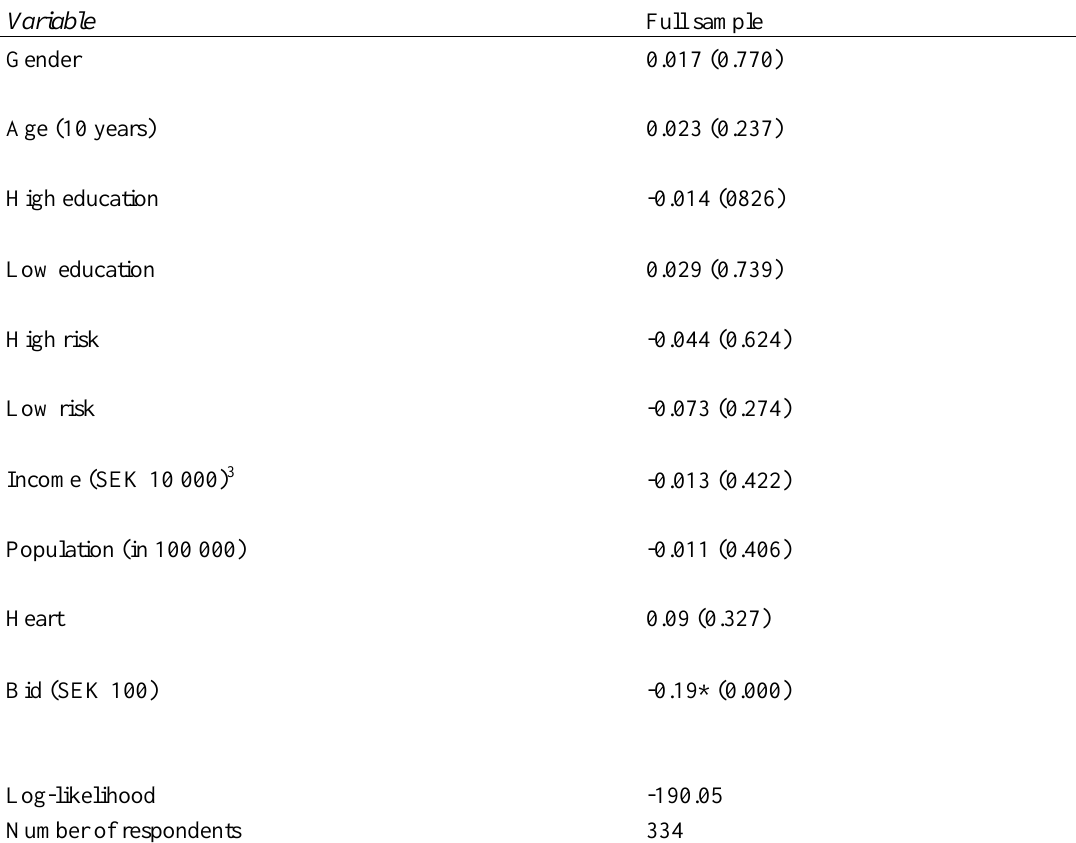
Estimated WTP (probability of a yes-answer), marginal effects